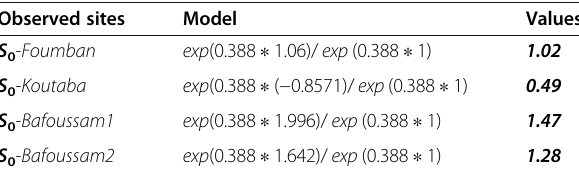
Table 12 Hazard ratios instantaneous risk models for the observed sites Observed sites